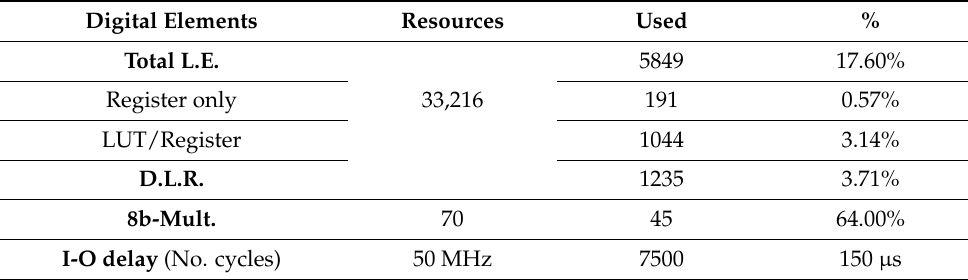
Table 7. Hardware resources used by Q H